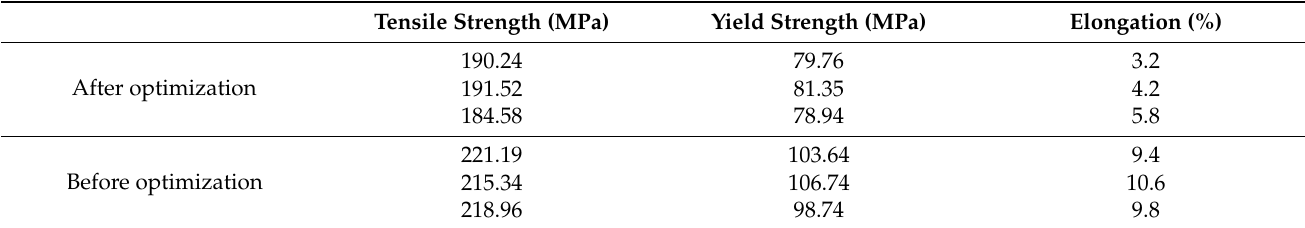
Table 7. Mechanical properties before and after